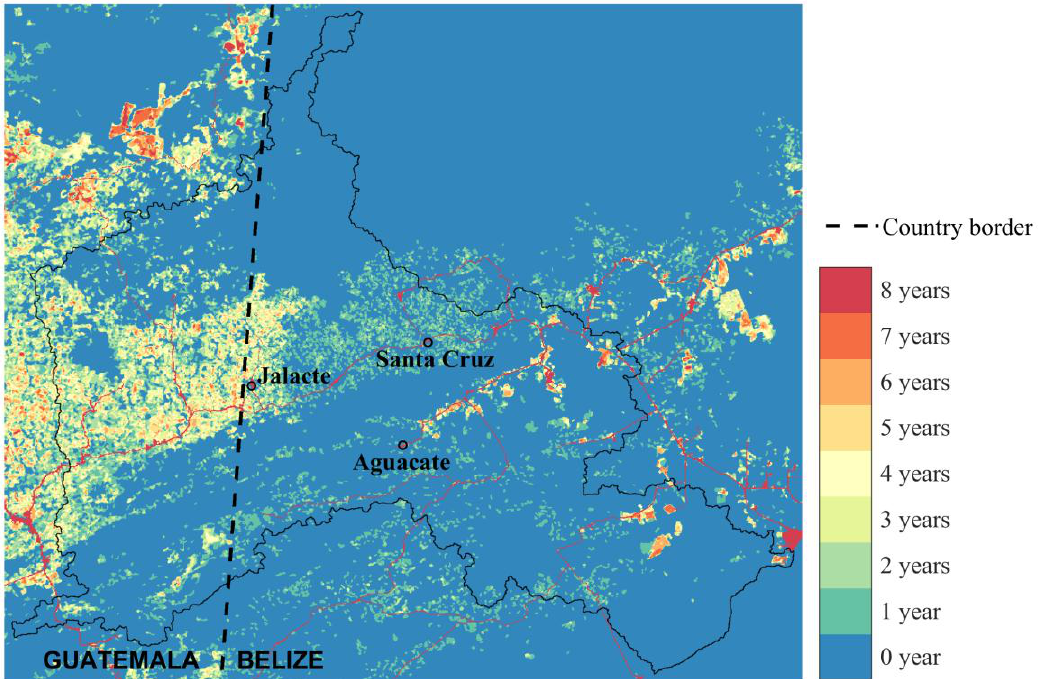
Figure 3. The frequency of land used for routine cultivation for the eight years of 1993–1996 and 1998–2001. While data for year 1997 was excluded due to heavy cloud cover, the time series is treated as continuous for this calculation. Land on the Guatemala side experiences more return cultivation, and land on the Belize side experiences less return use. Return cultivation or return use is defined as farmers cultivating an area that has been cultivated in prior consecutive years.